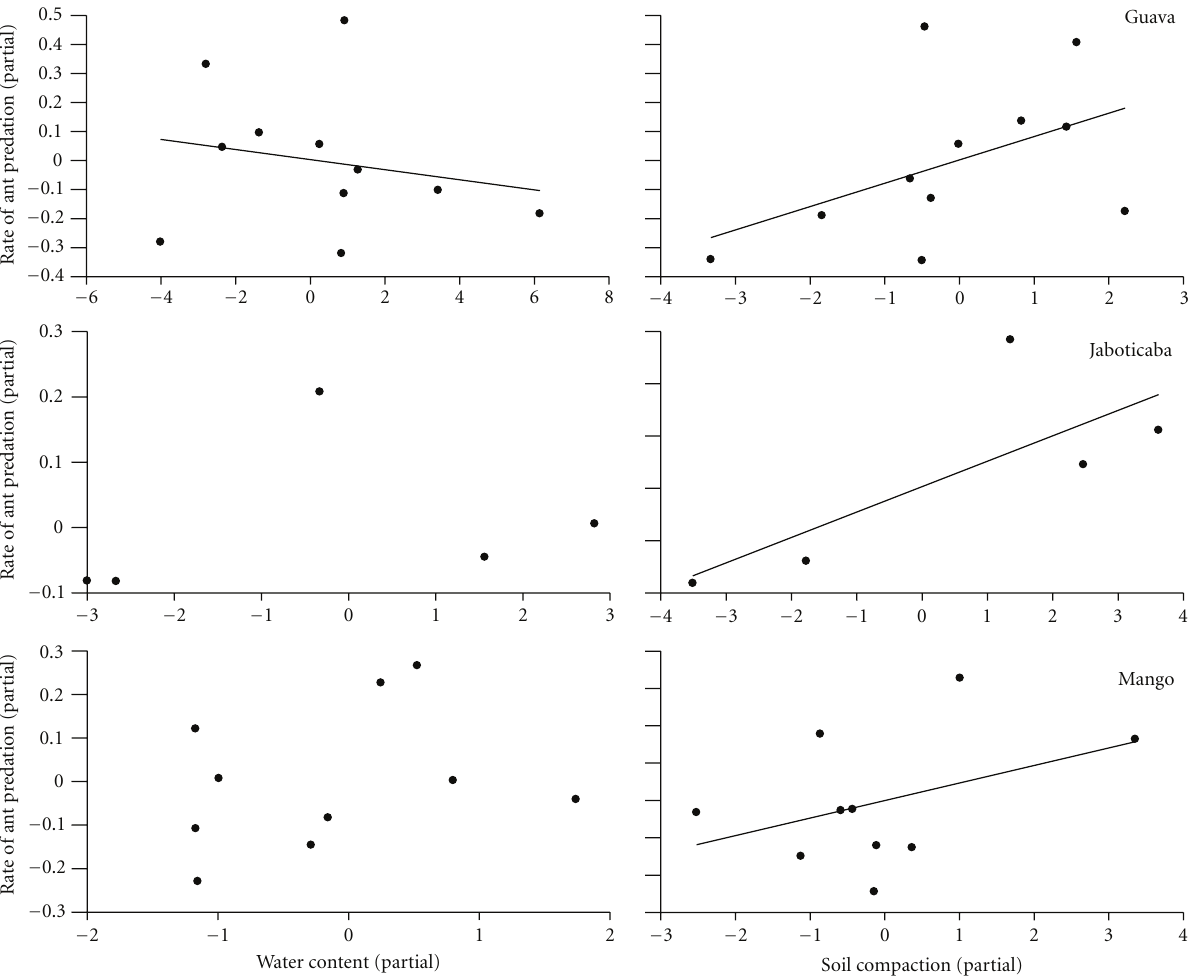
Figure 4: Ant predation on fruit fly larvae through gradients of water content and compaction of soil beneath the crowns of fruit trees of three species. Partial residuals obtained from multiple-linear model. Guava is Psidium guajava , jaboticaba Myrciaria jaboticaba , and mango Mangifera indica